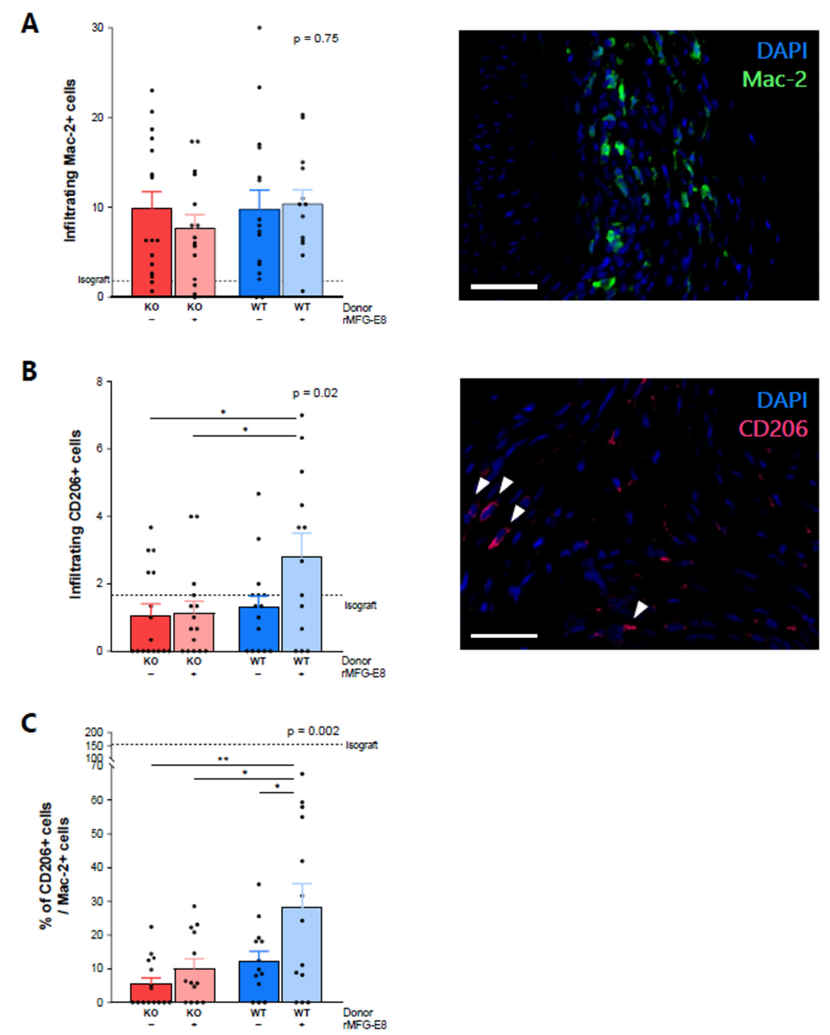
Figure 2. Effect of MFG-E8 on macrophage allograft infiltration. ( A ) Macrophage infiltration within the transplanted aorta, assessed by immunofluorescence positivity of Mac-2 + cells staining (in green). ( B ) CD206 + cell infiltration (pink staining) within the transplanted aorta. ( C ) Ratio of CD206 + cells/Mac-2 + cells. Values represent the average number of positive cells in three random areas. All data were assessed 9 weeks after transplantation. White bars represent 50 μ m. p -Value (upper right corner) indicates the overall ANOVA result. * p < 0.05, ** p < 0.01.